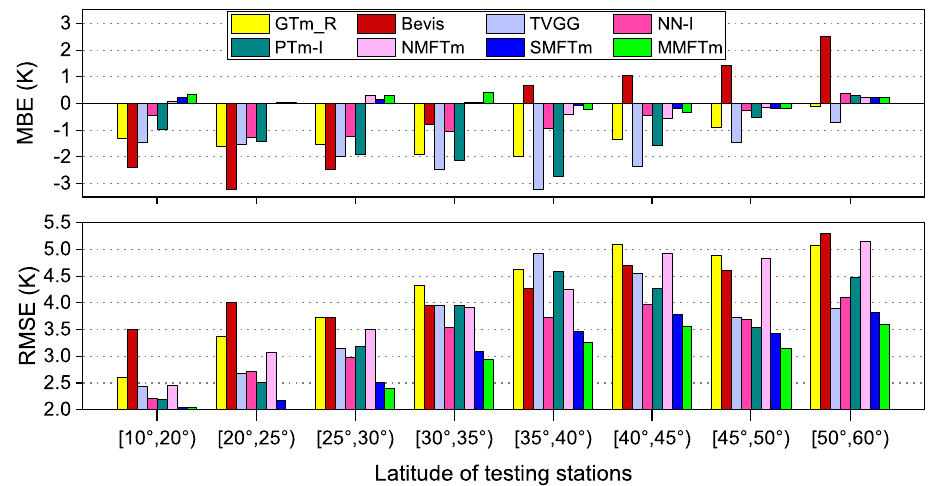
Figure 14. Results of MBE and RMSE for different models at different latitude